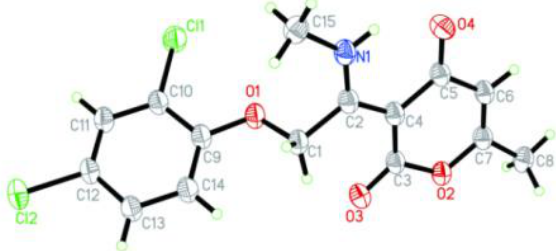
Figure 2. X-ray crystal structure of compound APD-I-9